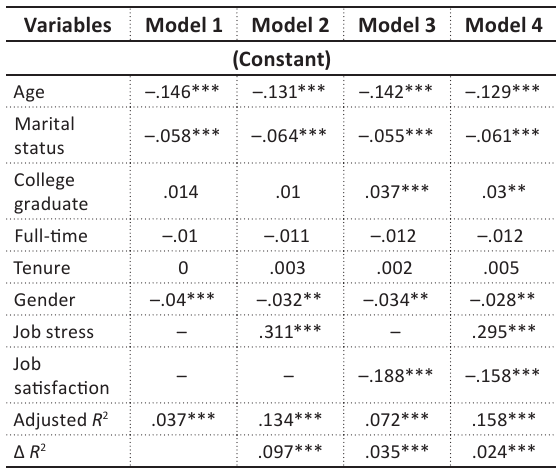
Table 2. Results of a regression analysis